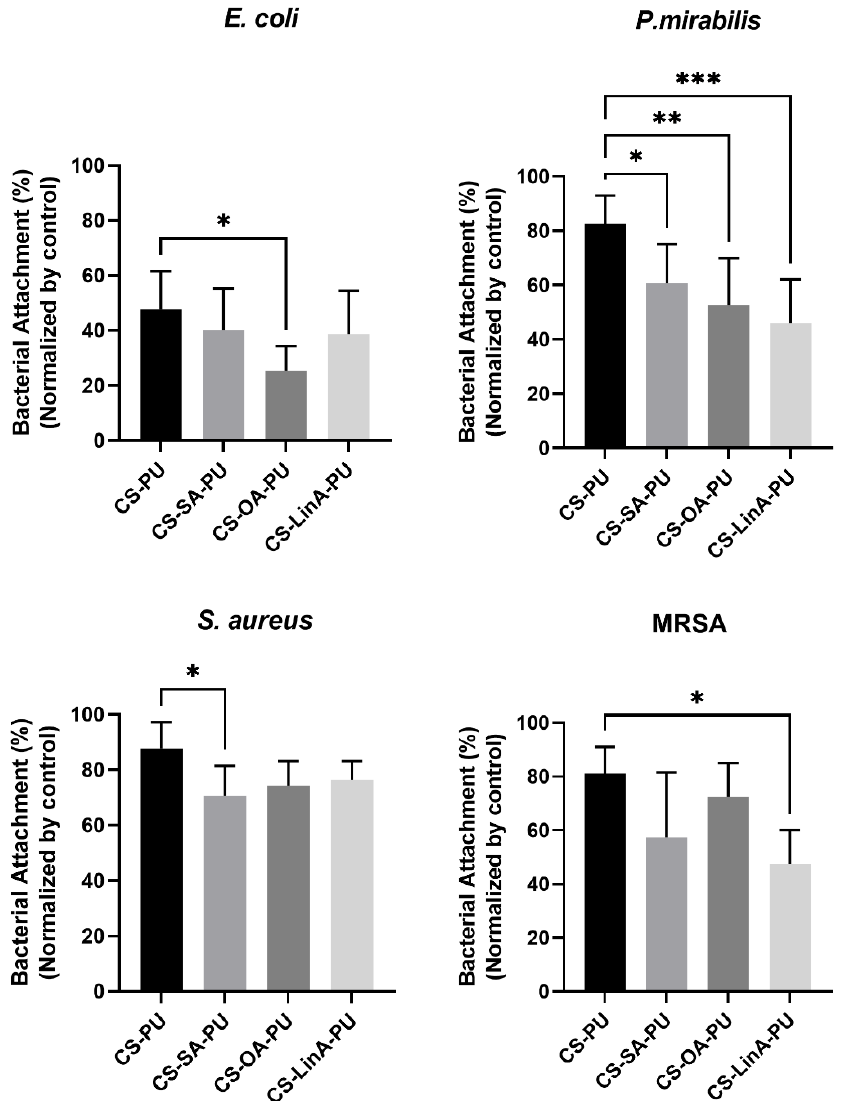
Figure 11. Percentage of adhered bacteria on the surface of CS-PU, CS-SA-PU, CS-OA-PU, and CS-LinA-PU upon 24 h exposure for each selected bacterial strain. The bacterial attachment percentage was ascertained utilizing the AB kit and normalized with control PU stent. Results were expressed as the mean ± standard deviation values of six independent assays conducted in triplicate. ***, p - value ≤ 0.001; **, p - value ≤ 0.01. *, p - value ≤ 0.05; ns, p -value > 0.05 (ns, no significant).